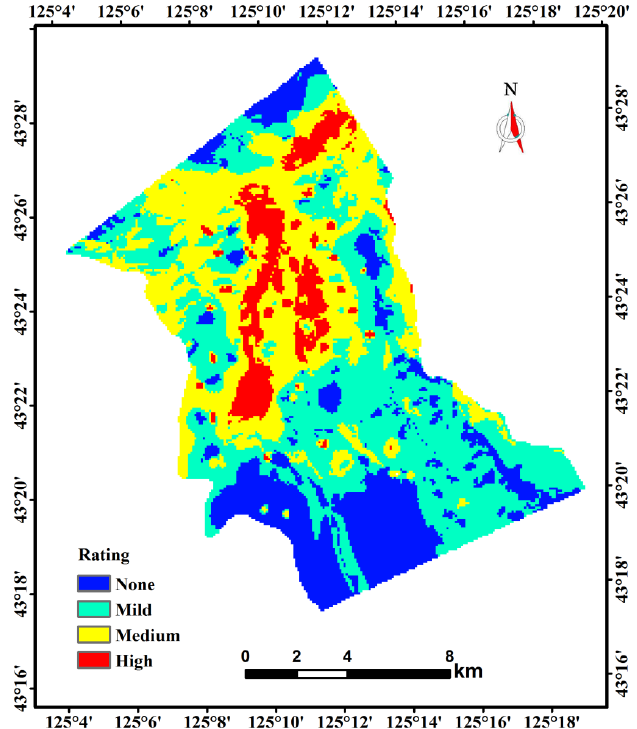
Figure 7. Groundwater pollution risk assessment rating mapping.